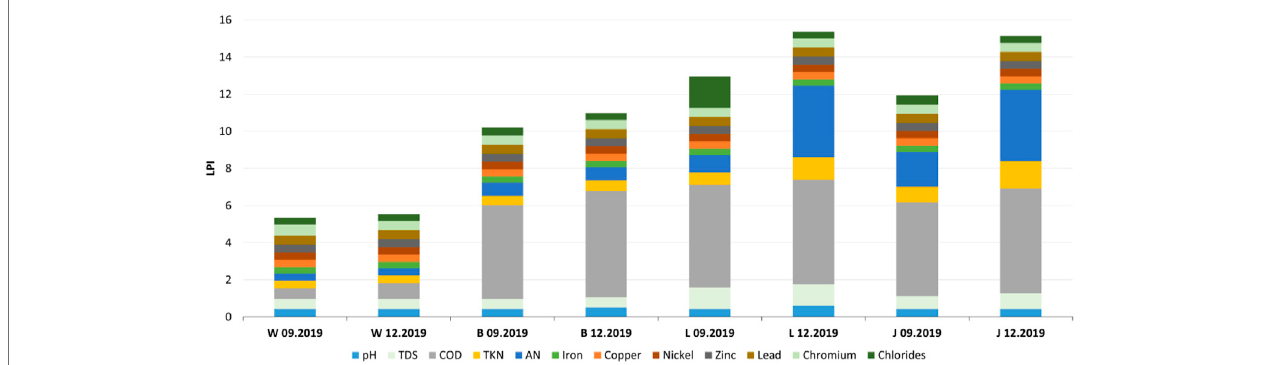
FIGURE 2 | LPI values and shares of particular parameters in calculated values for the investigated active (L-Legnica, J-Jawor) and inactive (W-Wroc ł aw, B-Bielawa) land fi lls.